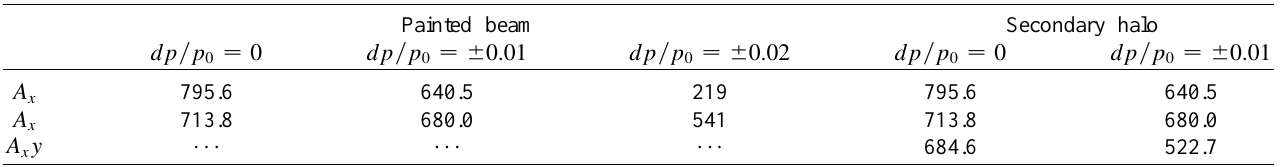
TABLE I. Minimum aperture around the ring for the main quadrupole and dipole magnets. In the first three columns, the acceptance is calculated for the uncoupled painted beam where e x and e y are independent. For the secondary halo, we assume a coupled beam. Units are in p mm mrad. Painted beam Secondary